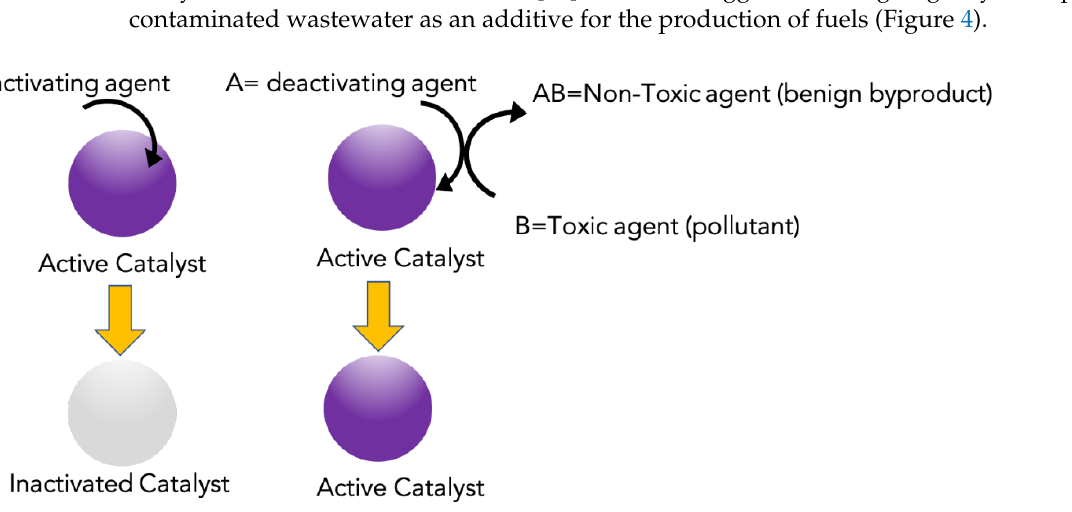
Figure 4. Scheme representing the use of toxic or unwanted reagents/byproducts to prevent catalyst’s deactivation. See [43] for details.